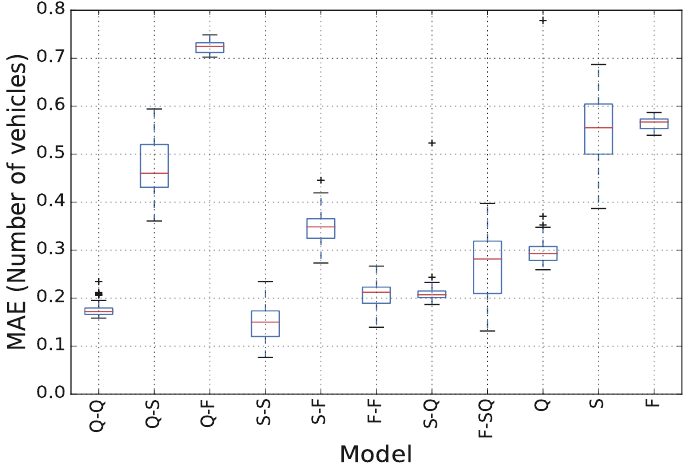
Figure 8. Disaggregated model performance considering different speed thresholds for vehicle phase